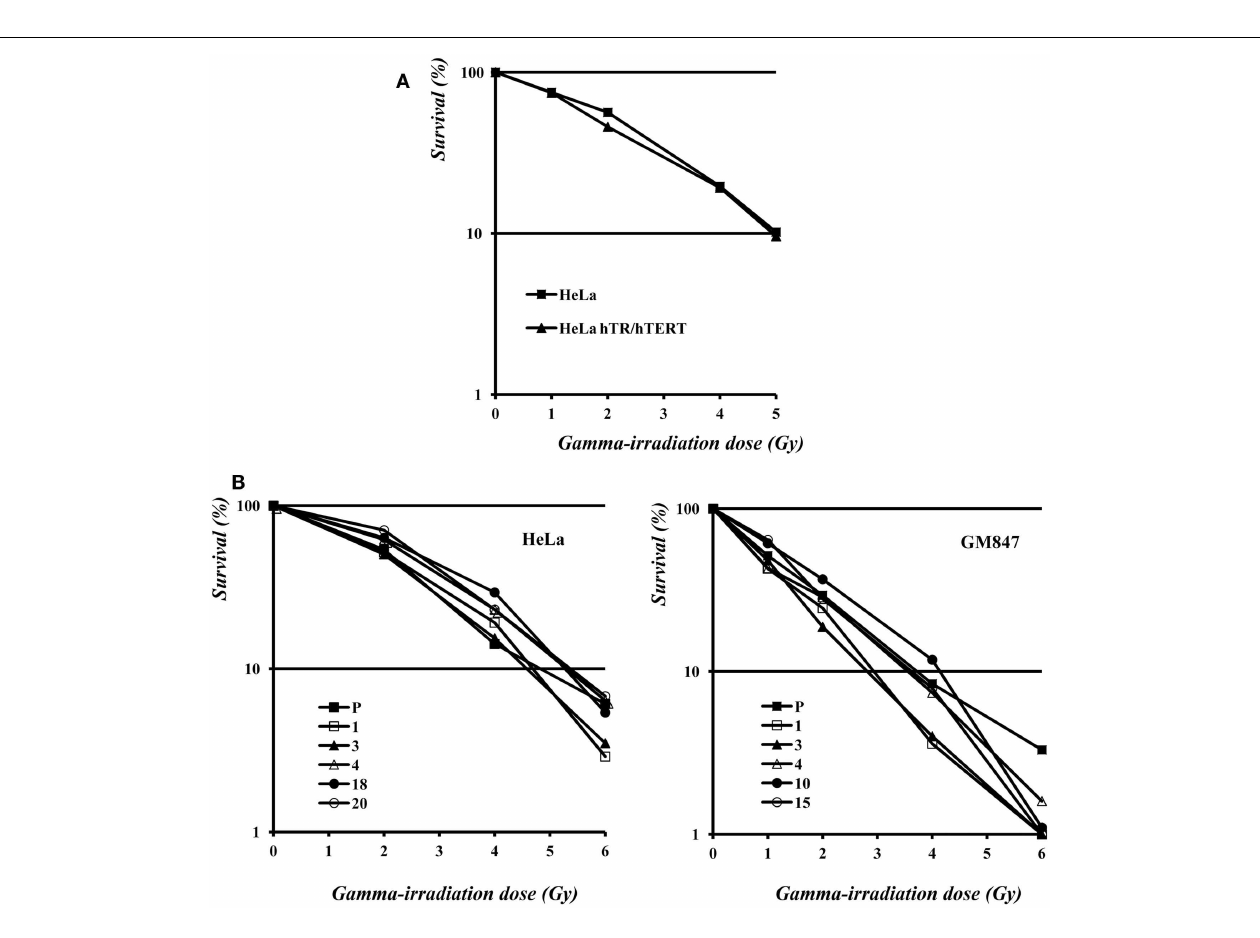
FIGURE 5 | (A) Survival to γ -irradiation of HeLa and hTR/hTERT cells. (B) Survival to γ -irradiation of HeLa (left) and GM847 (right) cells and of their clones.